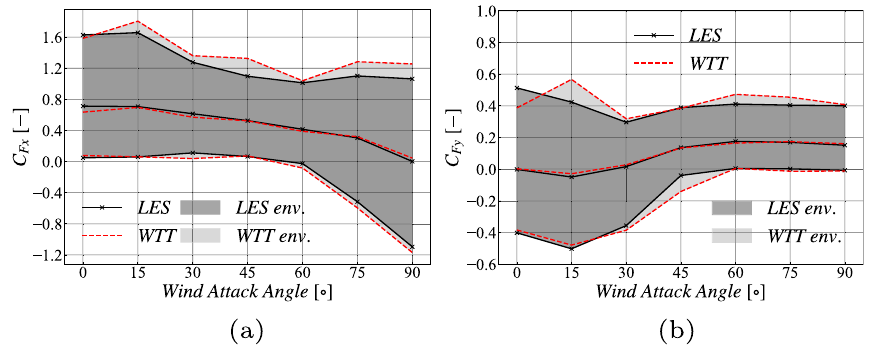
Fig. 8 The global forces coefficients of all the simulated wind attack angles: ( a ) C Fx and ( b ) C Fy